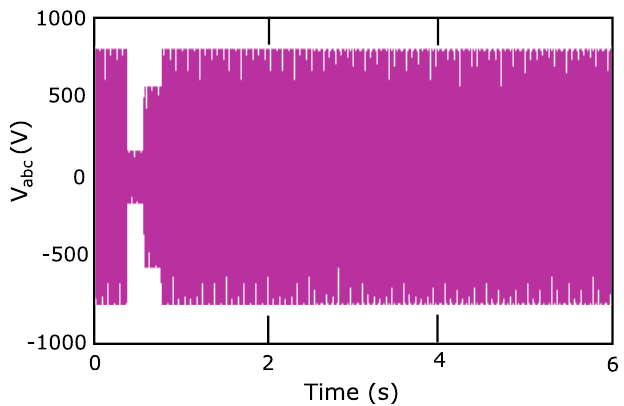
Figure 17. Voltage dip applied to Type 1 and 2